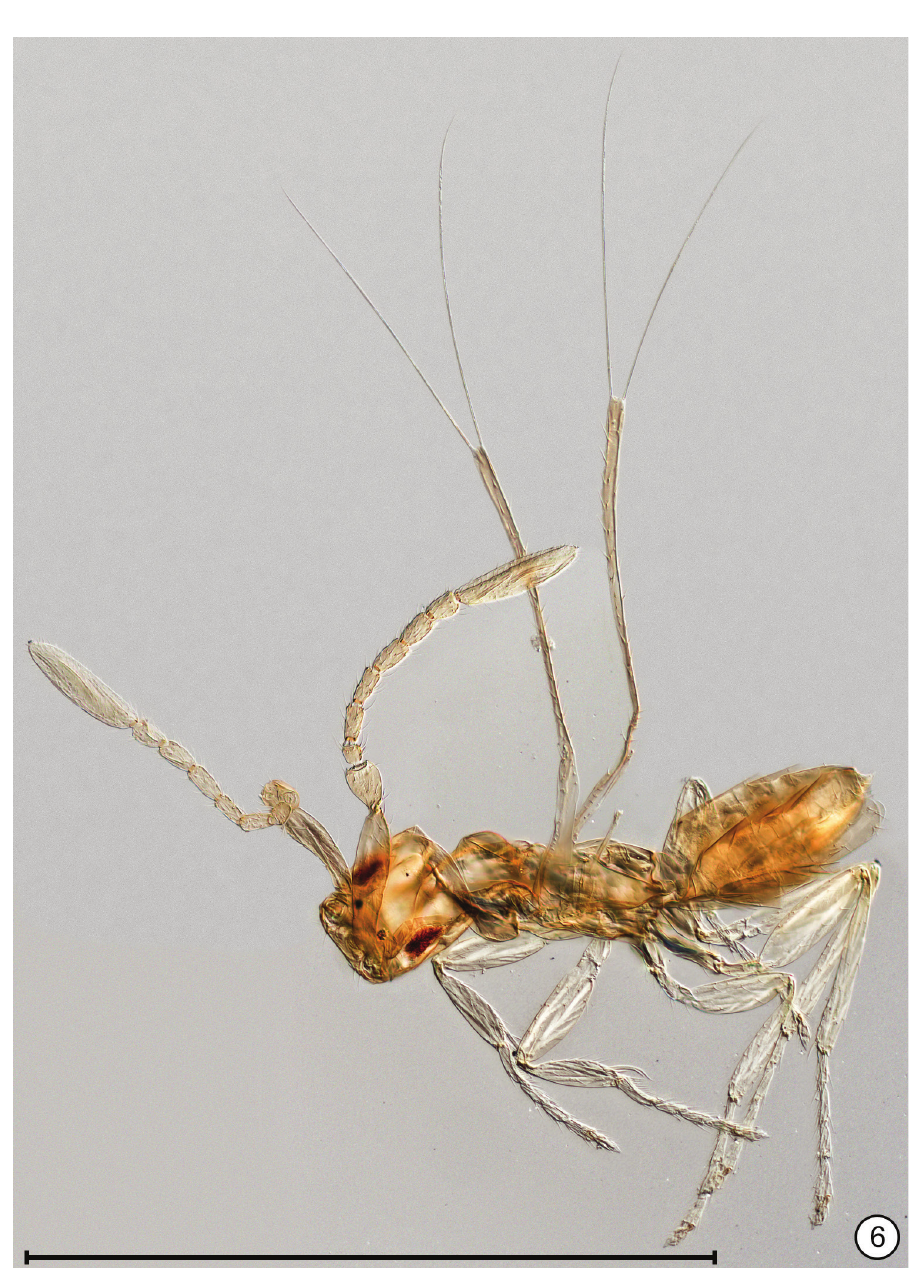
Figure 6. Cleruchus biciliatus (Ferrière), paratype habitus. Scale bar: 500